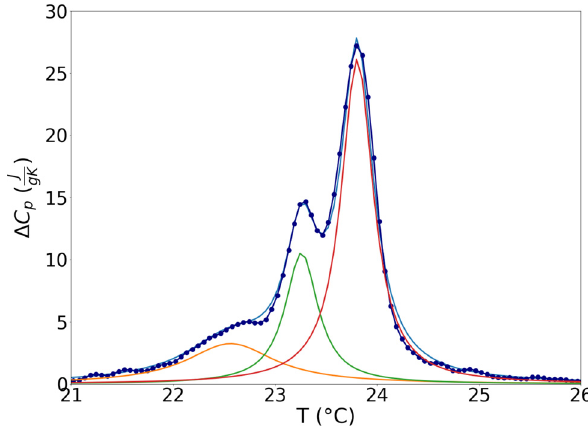
Figure 3: Fit of Δ C p ( T ) trend for DMPC LUVs after the last EVs addition to the system.